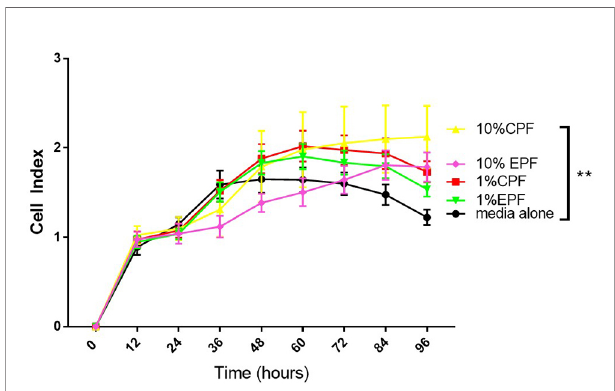
FIGURE 1 | Peritoneal fl uid increases proliferation of TOV-21G cells as determined by increase in Cell Index. **p < 005.